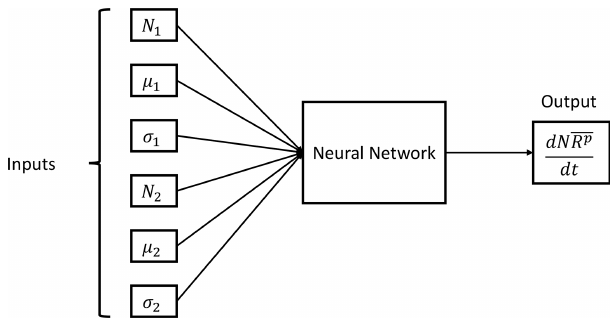
Figure 3. Neural network parameterization inputs and output. The input data are the six distribution parameters ( N 1 , µ 1 , σ 1 , N 2 , µ 2 and σ 2 ) needed to feed Eq. (13), while the output is the p th order (cid:16) d NR p (cid:17) total moment tendency . d t Table 1. Statistical description of the input values used in the train- Figure 4. Scatterplot of liquid water content (LWC) calculated from ing and test data sets. The means, standard deviation and ranges are the input parameters of f 1 (a) and f 2 (b) vs. drop number concen- shown for each input variable. tration. The LWC values are obtained from the statistical moment of order 3 using the parameters depicted in Table 1 and were calcu- lated from Eq. (4). The red dots represent the initial conditions for the experiment case included in Table 4. Only 1 in 100 data points are